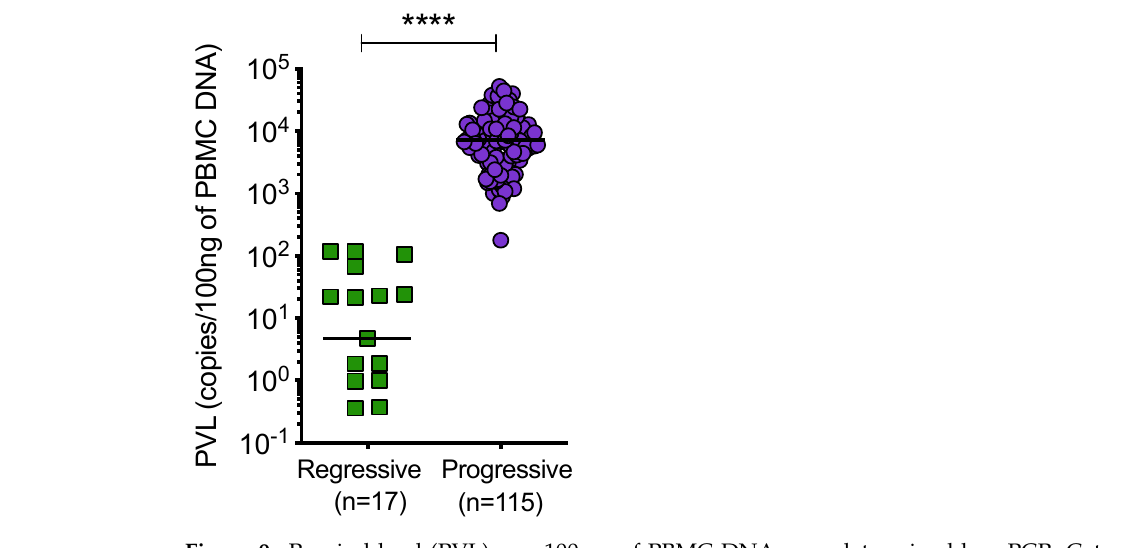
13 of 22 Figure 8. Plasma antigenaemia was measured using the IDEXX FeLV PetChek ® ELISA. Timepoint 1 (TP1) and timepoint 2 (TP2) p27 capsid antigen (Ag) concentrations were compared within each of the exposure outcome groups. Statistical significance was determined using Wilcoxon matched- pairs signed rank test ( p -value < 0.05 *). 3.6. Proviral Load of Samples from Cats with Regressive and Progressive Infection